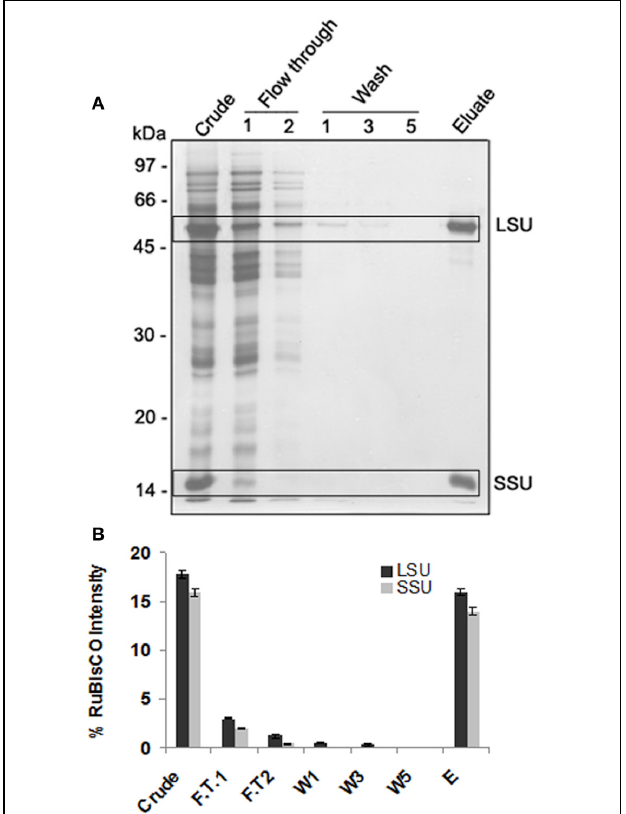
FIGURE 2 | 1-DE of RuBisCO depleted fractions and its comparison with the crude proteins displaying substantial removal of RuBisCO. (A) SDS-PAGE (12%) gel showing RuBisCO depletion after immunoaffinity purification using Seppro IgY-RuBisCO spin column kit. Large (LSU) and small (SSU) subunit of RuBisCO are marked in boxes. (B) Relative intensity of the polypeptides of LSU and SSU of RuBisCO quantified using densitometric scanning (AlphaImager software, Alpha Innotech Corporation). Polypeptide intensities were calculated by subtracting the background intensity. The results are representative of three biological